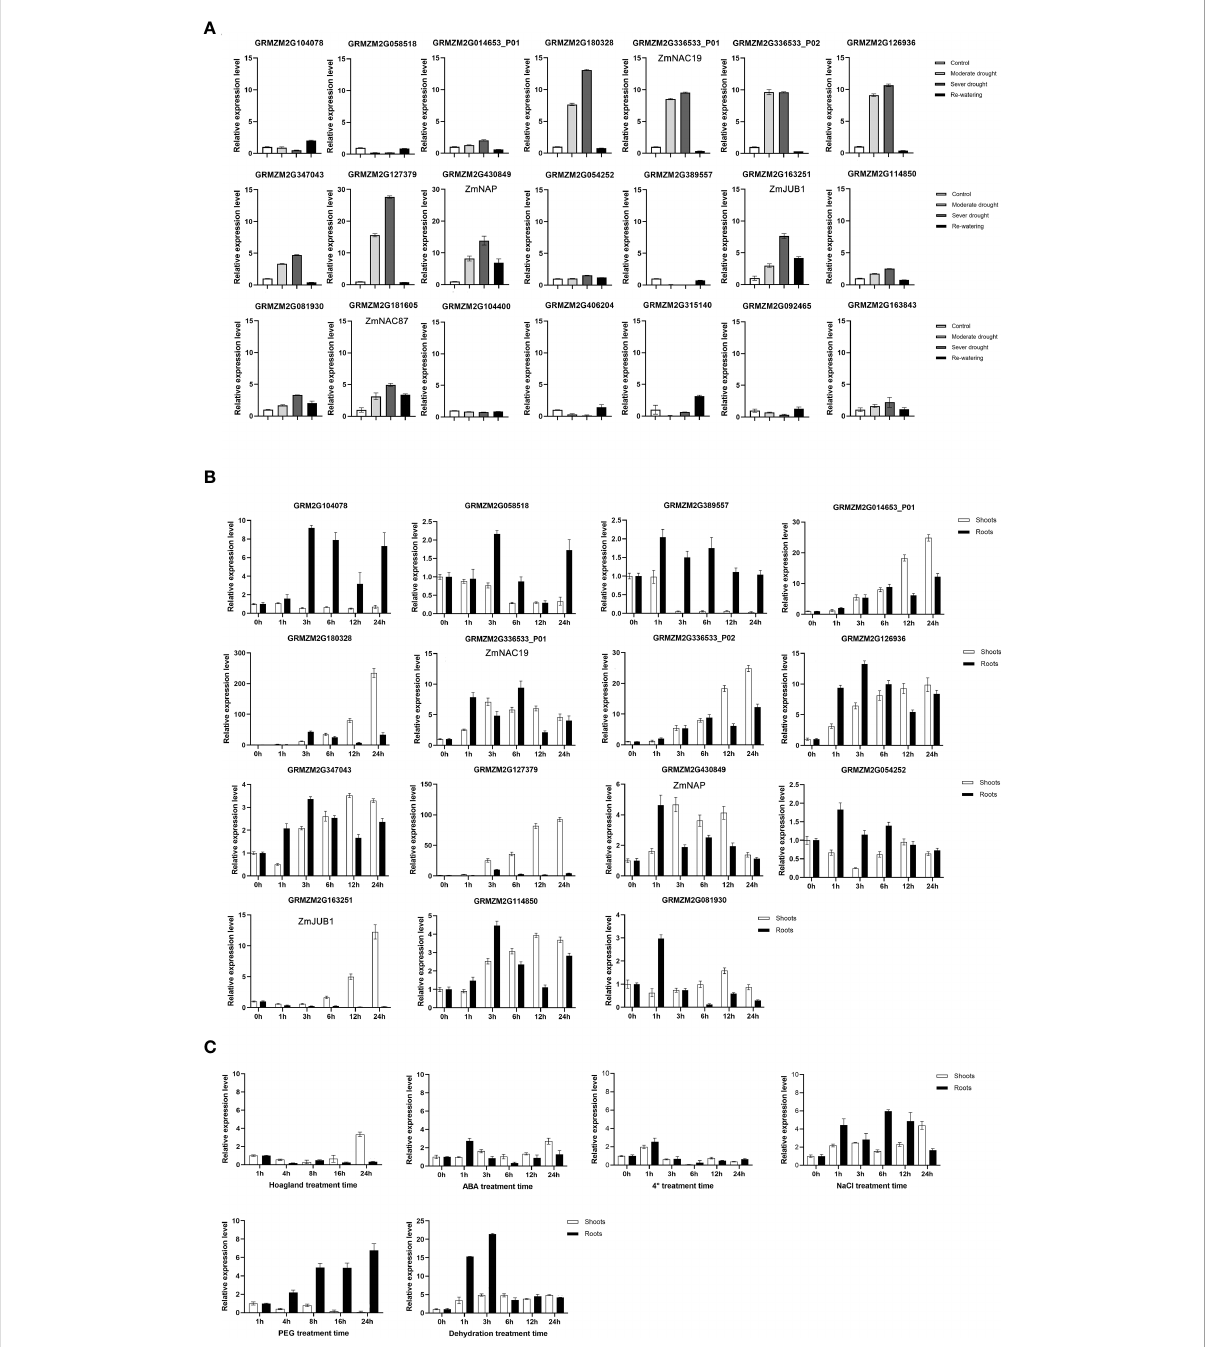
FIGURE 3 Expression levels analysis of maize NAC genes. (A) Expression analysis of 21 maize NAC genes under drought stress treatments. (B) Expression analysis of 15 maize NAC genes under dehydration treatments. Maize ZmGAPDH (NM_001111943) was used as the internal reference gene. (C) Expression patterns of ZmNAP in shoots and roots when treated with 200 mM NaCl, 100 m M abscisic acid (ABA), 20% PEG, dehydration, low temperature (4°C), drought stress, and control (Hoagland), respectively. The maize ZmGAPDH ( NM_00111943 ) gene was used as an internal control for